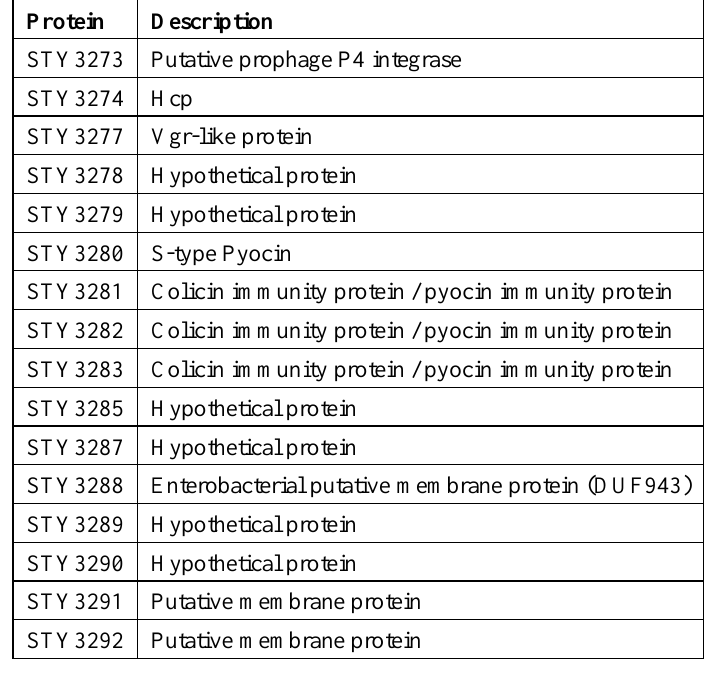
Table 3: List of proteins encoded by SPI-8. At the early stage of infection, S. Typhi may use bacteriocin (pyocin) to kill other bacteria in the intestine in order to compete for nutrients. Remarks: Hypothetical protein refers to the predicted protein but without any putative function. Putative is a protein that has function predicted based on sequence